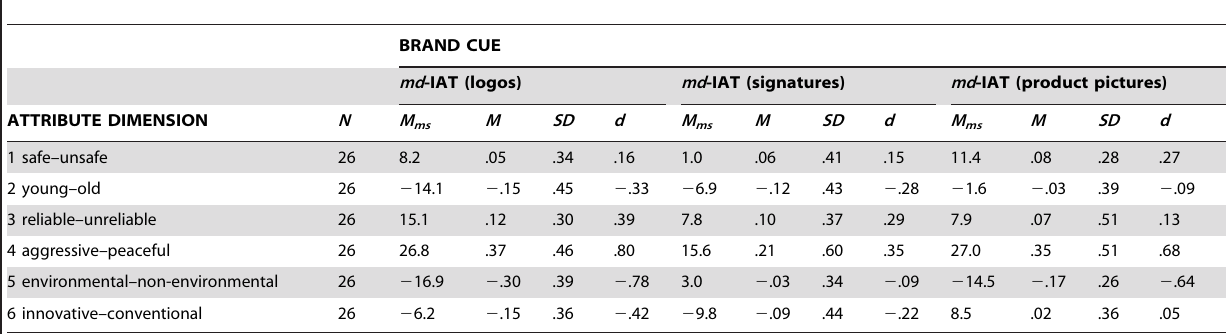
Table 3. Study 1: Summary of all 18 single IATs with factors ATTRIBUTE DIMENSION and BRAND CUE (6 6 3).